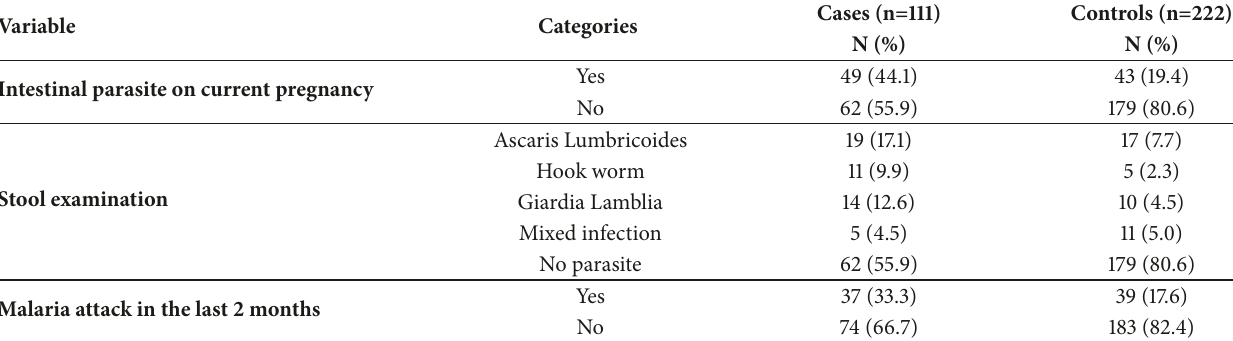
Table 4: Parasitic infection related characteristics of pregnant mother attending ANC in public health facilities of Durame Town, February to May